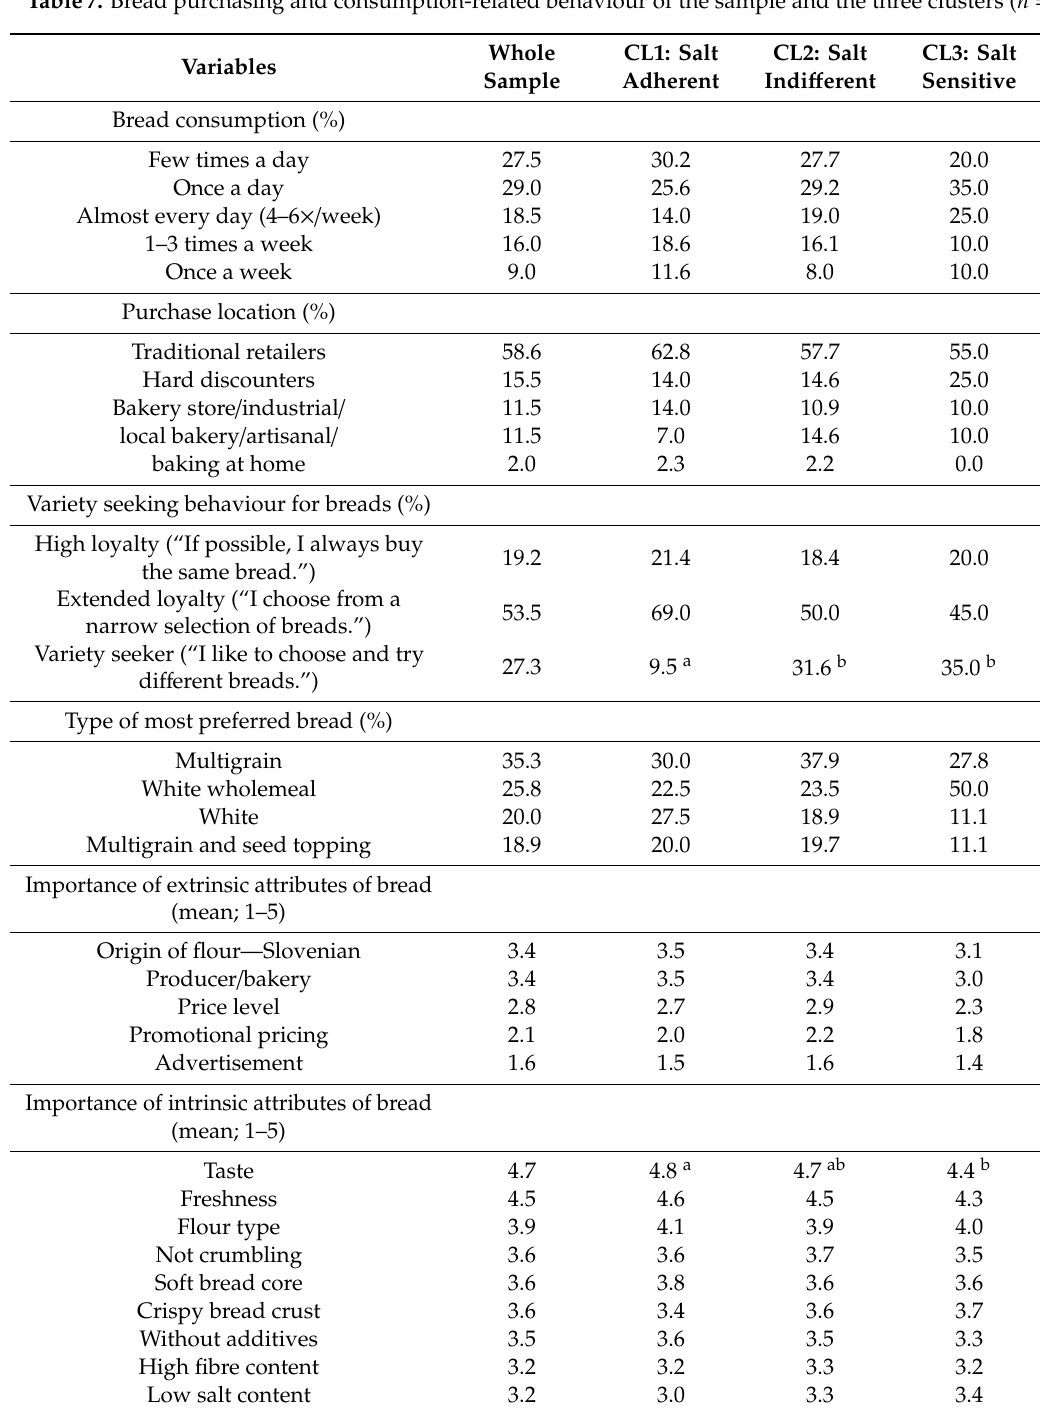
Table7. Bread purchasing and consumption-related behaviour of the sample and the three clusters ( n =